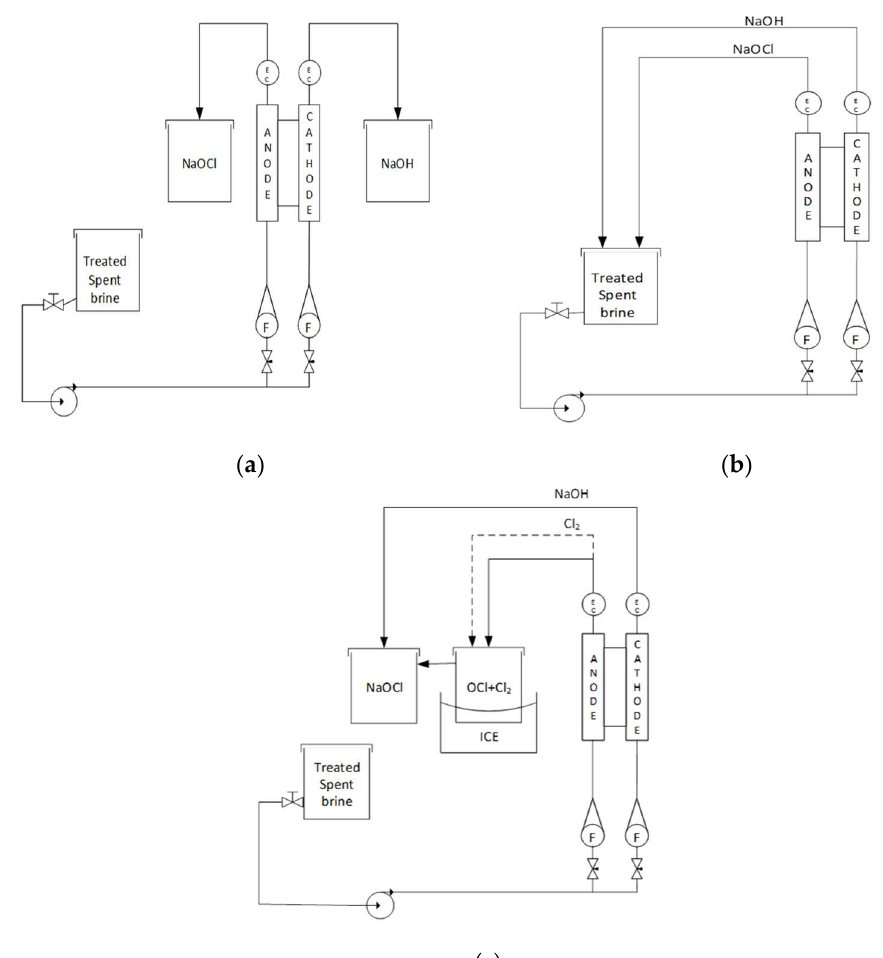
Figure 2. Spent brine treatments. ( a ) Regular process: the spent brine is fed to the cell and the NaOCl and NaOH are were collected in separate tanks. ( b ) Recirculation process: the spent brine is initially pumped to the electrolytic cell; afterwards, the obtained NaOCl, as well as the unreacted NaCl, are recirculated back to the holding tank and repumped to the cell for a fixed time and flowrate. ( c ) Bubbling process: the brine is pumped into the cell and the obtained NaOCl is conducted to a cooled container with the objective of separate the chloride water and the gas. The resulting gas is further injected into other container and put in contact with NaOH solution.